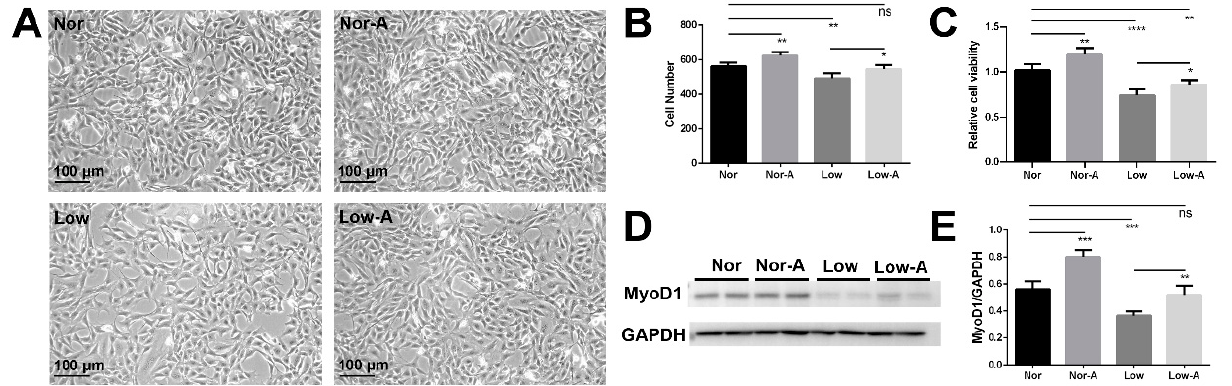
Figure 1. Proliferation and differentiation abilities of C2C12 myoblasts under the conditions of normal culture and low- glucose culture. ( A ) Myoblasts morphologies. ( B ) Cell numbers corresponding to panel A ( n = 4). ( C ) Cell viabilities relative to Nor cells analyzed by MTS cell proliferation assay ( n = 5). ( D ) MyoD1 expressions in myoblasts analyzed by western blot. The anti-GAPDH antibody was used to standardize the amount of protein in each lane. ( E ) Statistical analyses corresponding to the panels ( D ) ( n = 4). * p < 0.05, ** p < 0.01, *** p < 0.001, **** p < 0.0001.